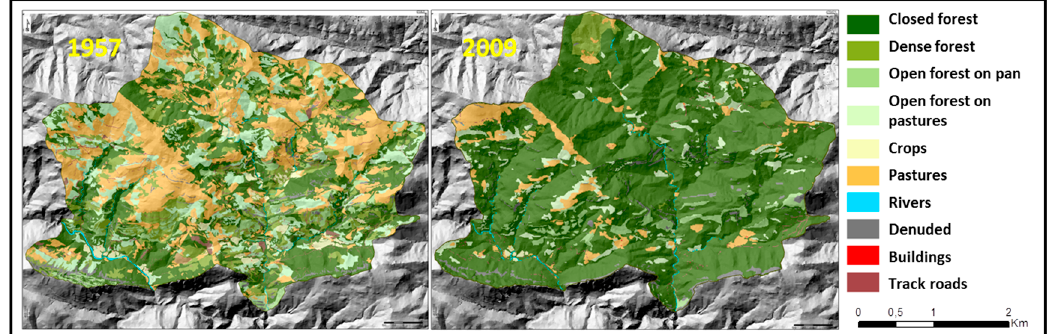
Figure 2. Land use and cover maps (1957–2009).